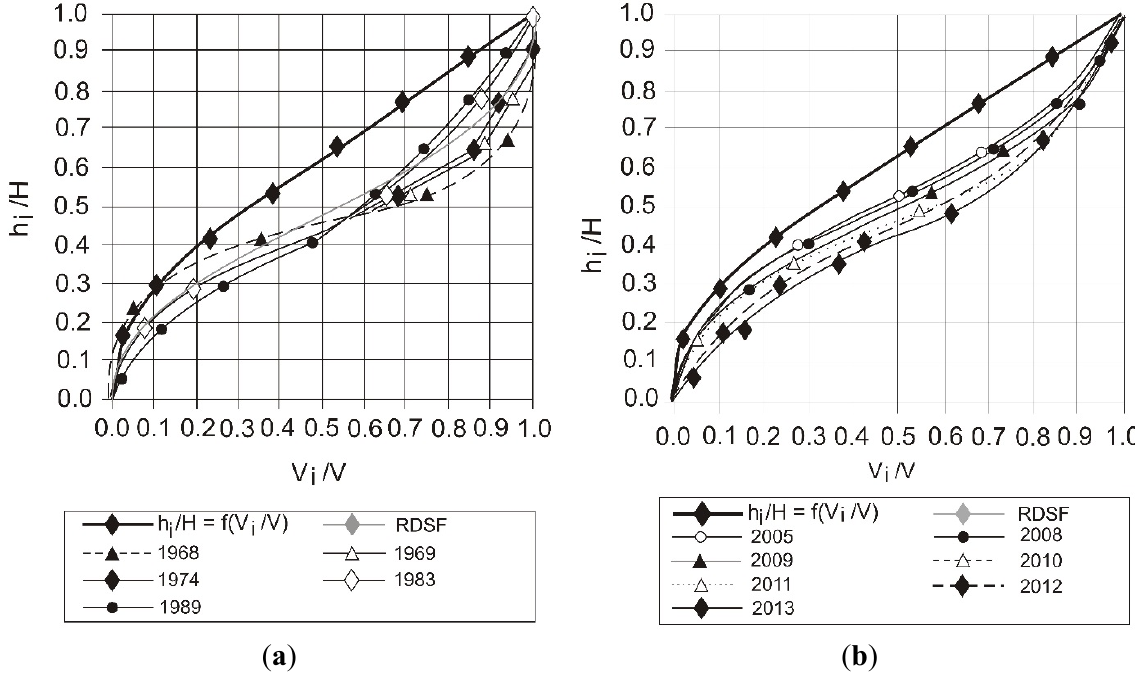
Figure 5. Comparison of cumulative depth of sediment deposition in reservoir Zes ł awice-1, described with function h i /H = f ( V i /V ), with relative cumulative sediment distribution described according to RDSF parameter; where h i /H is the relative depth, and V i /V is the relative volume, rel. V is the cumulative curve of the reservoir’s volume; ( a )—reservoir before dredging; ( b )—reservoir after